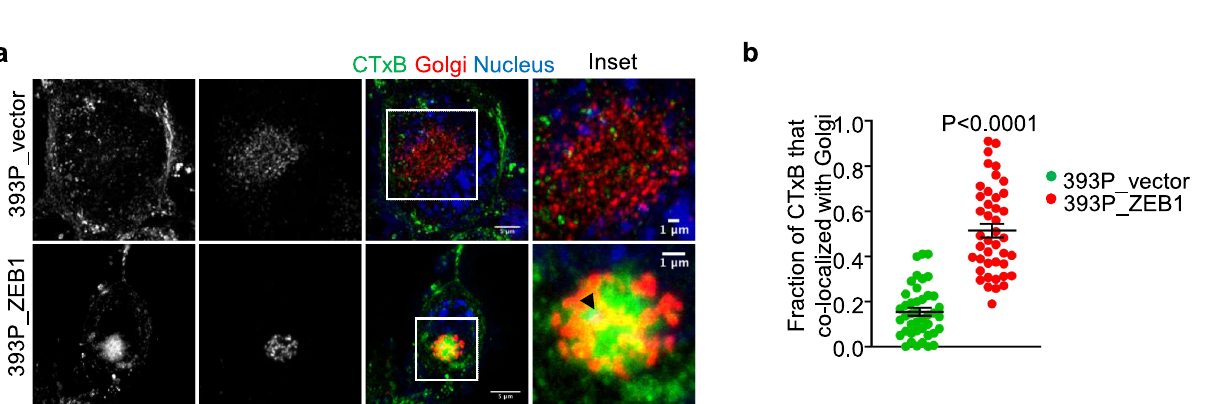
Fig. 6 ZEB1 accelerates retrograde vesicular traf fi cking. a Single-channel and merged confocal micrographs taken 1 h after initiating Alexa 488-labeled cholera toxin B (CTxB) treatment. Boxed areas are magni fi ed (insets) to show greater CTxB co-localization with Golgi in 393P_ZEB1 cells than 393P_vector cells. Scale bars: 5 µ m, 1 µ m (inset). b Fraction of total CTxB that co-localizes with GM130, a Golgi marker, in each cell (dot). n = 42 cells from 3 independent experiments. Data are presented as mean values± SEM; P values, two-tailed Student ’ s t